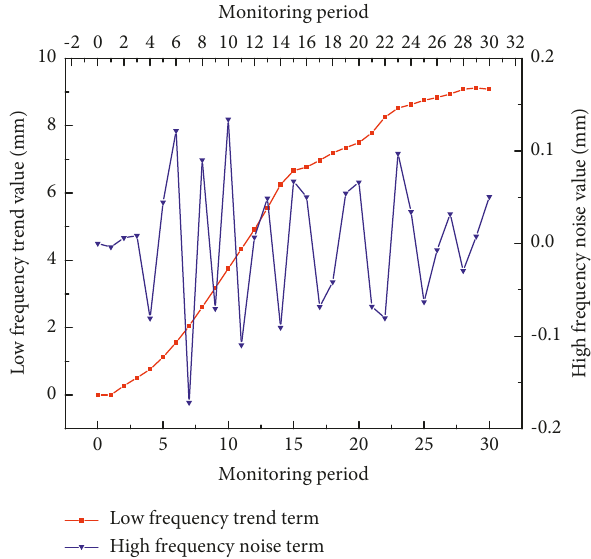
Figure 5: Low-frequency trend item and high-frequency noise item of KQ1-Z subsidence monitoring